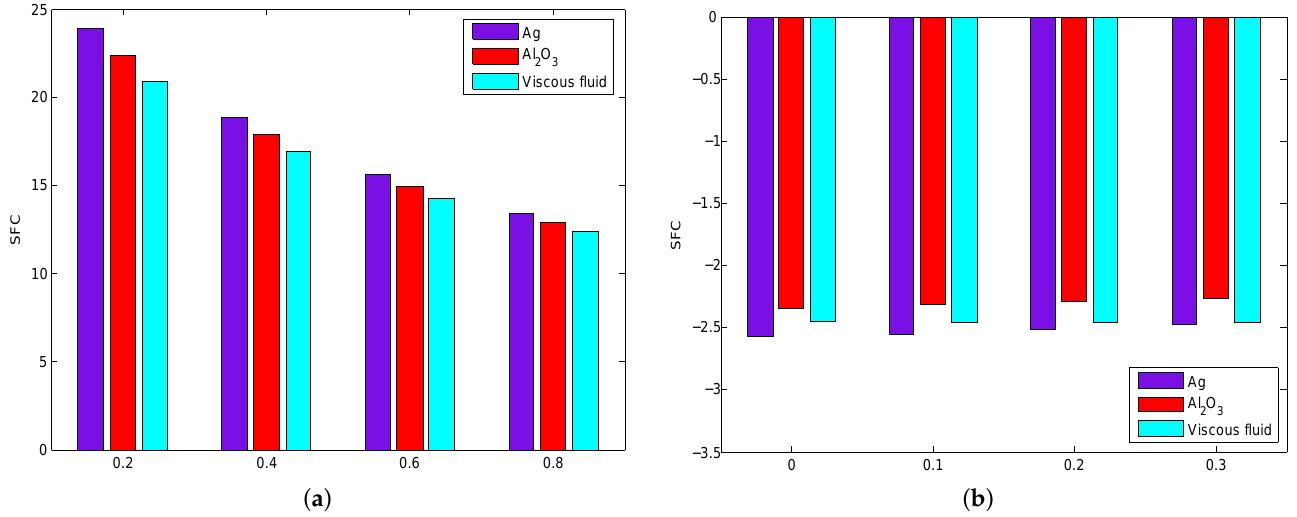
Figure 11. The increasing/declining percentage of SFC on ( a ) Λ and ( b ) fw